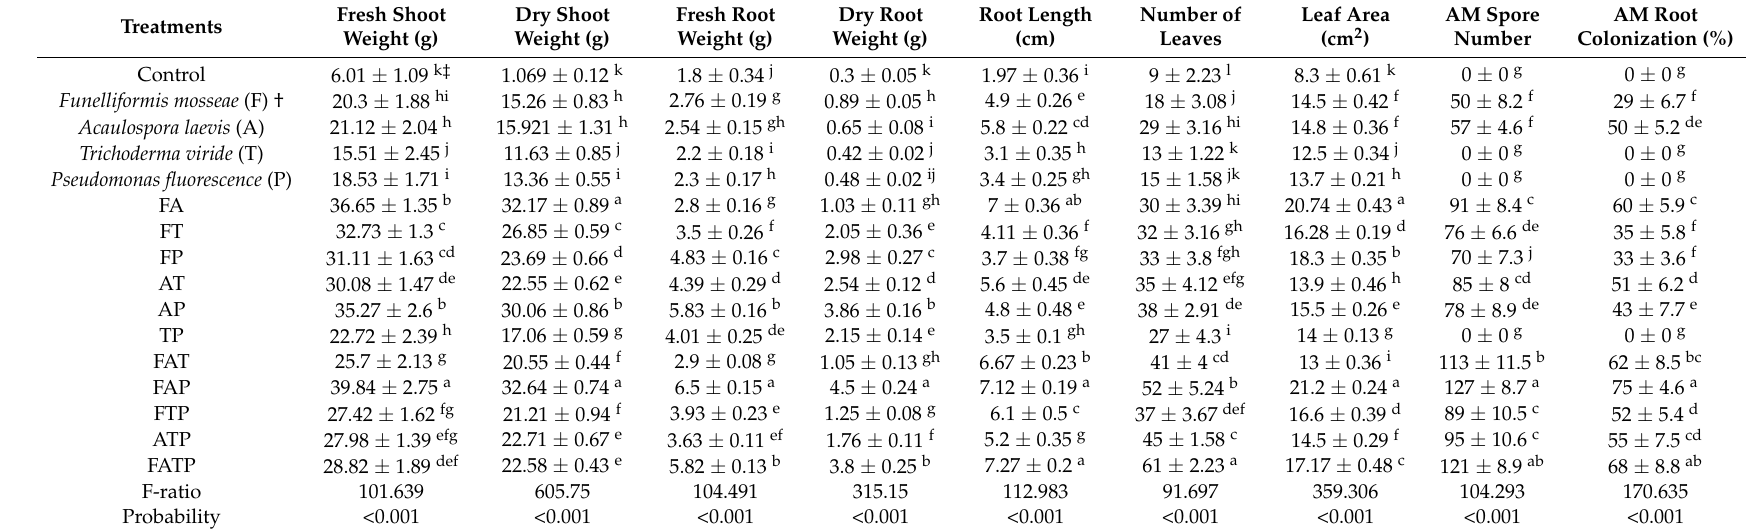
Table 2. Effect of bioinoculants on morphological parameters of Gazania